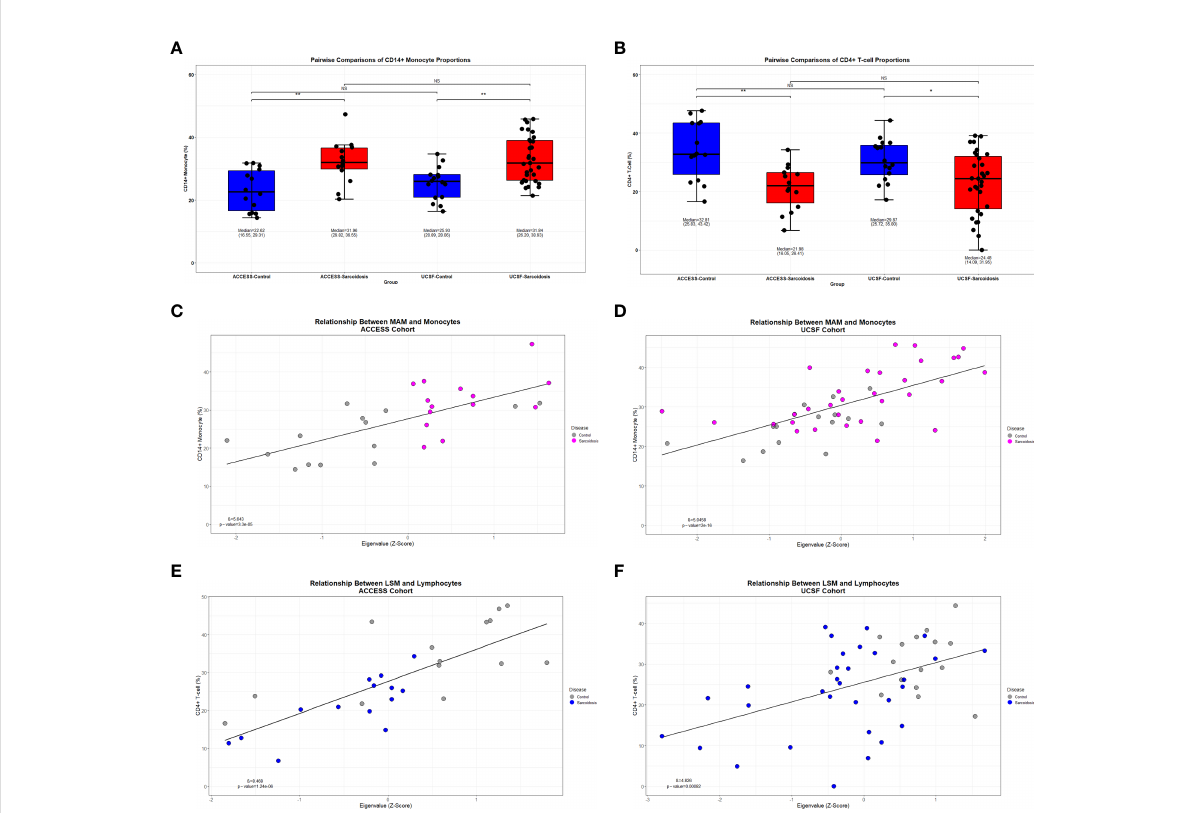
FIGURE 7 Decreased lymphocyte abundance in sarcoidosis linked to MAM and LSM transcription factors. (A, B) Box plots demonstrating the distribution of CD14+ monocyte and CD4+ T-cell in ACCESS and UCSF cohorts based on case-control grouping. PBMC subpopulation proportions were derived from in-silico cellular deconvolution utilizing Cibersort and the Immunostates gene signature matrix. Sarcoidosis cases in both cohorts were found to have signi fi cantly lower percentages of CD4+ T-cells when compared to controls within the same cohort. Comparable cell proportions were found among cases and controls between cohorts. For each group, corresponding median, 1 st quartile, and 3 rd quartile values are shown. P-values are shown above brackets for each pairwise comparison: NS, non-signi fi cant; *p-value < 0.05, **p-value < 0.01; Mann- Whitney U Test. (C – F) Linear regression identi fi ed signi fi cant associations between module eigengenes and cell subset proportions (p-value <0.05). CD14+ monocytes were signi fi cantly associated with MAM expression in the ACCESS (C) and UCSF (D) cohorts. CD4+ T-cells were signi fi cantly associated with LSM expression in the ACCESS (E) and UCSF (F)